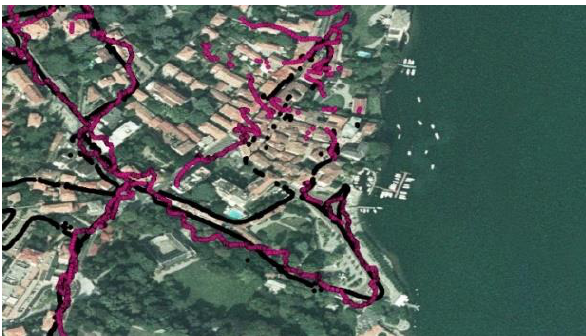
Figure 12. Details of two different acquisitions with a geodetic device – Leica GPS 1200 receiver (black route) and a low cost GNSS receiver - Nexus 6P (purple route).